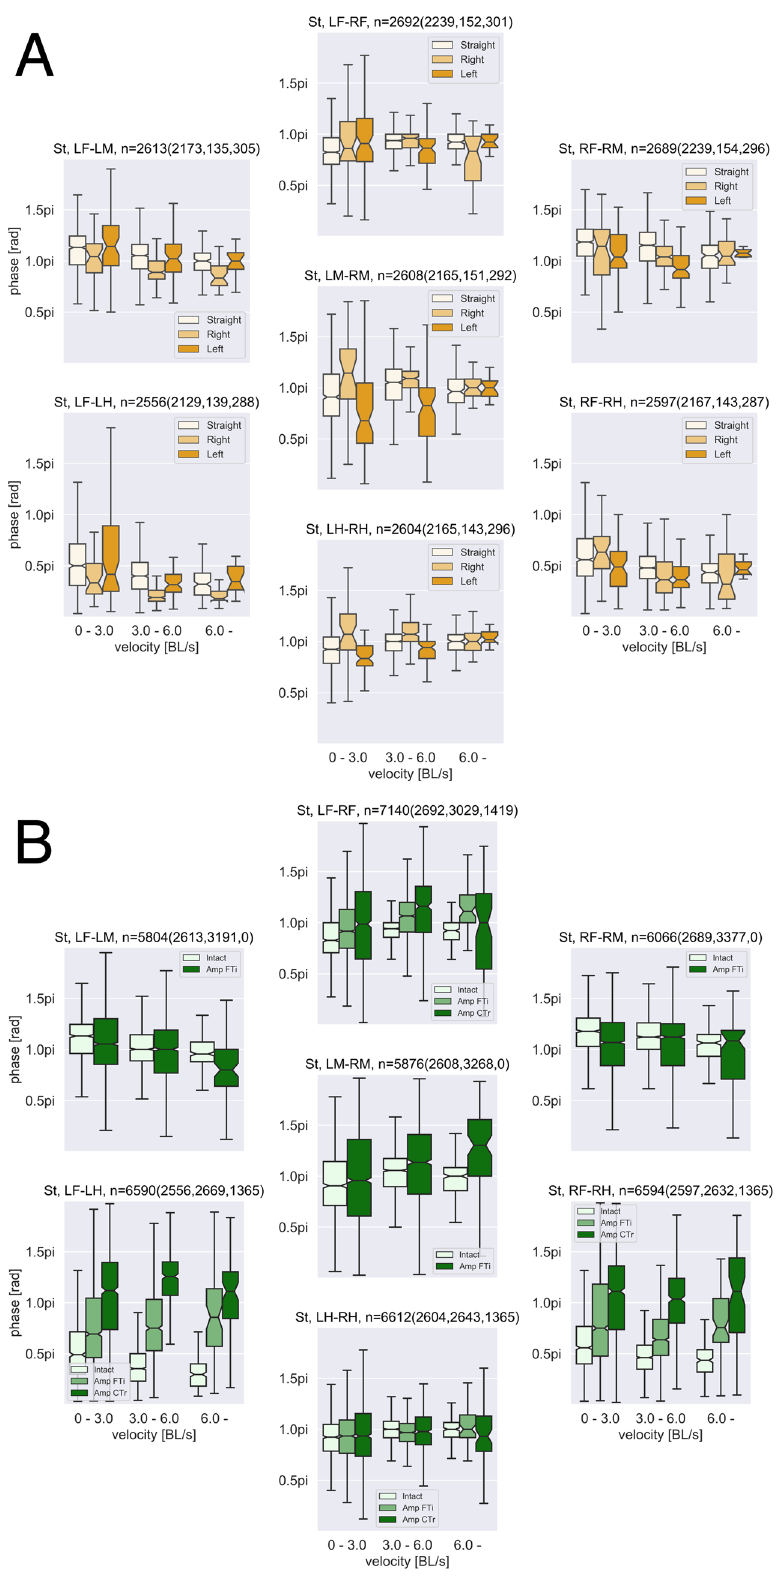
Figure 2. ( A ) Effect of body rotation on leg coordination. ( B ) Effect of leg amputation on leg coordination. Each panel on A and B show phase differences between foot contact timings (from swing to stance phases) of legs (left top: LF-LM, left bottom: LF-LH, centre top: LF-RF, centre middle: LM-RM, centre bottom: LH-RH, right top: RF-RM, right bottom: RF-RH). n indicates the analysed periods for each panel ( A : n = All (Straight, Right, Left) and B : n = All (Intact, Amp FTi, Amp CTr)). In ( A ), the colour difference in each − 1.0 1.0 panel represents walking direction: Straight = − 1.0 to 1.0 rad/s, Left > rad/s, Right < rad/s. In ( B ), the colour difference represents the conditions of A, B, and C in Fig. 1. Horizontal axes represent walking velocity (from 0.0—3.0, 3.0–6.0, 6.0–